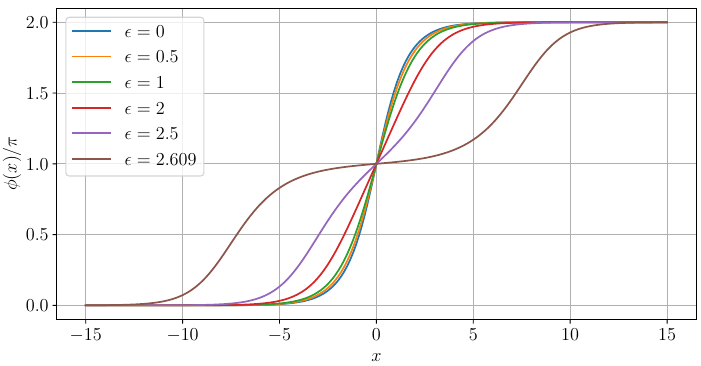
Figure 1 . The potential of the model (2.1) for various values of the parameter (cid:15) . Note that the first and last values plotted are outside the range considered in this paper: for (cid:15) = − 0 . 005 the potential is unbounded below, while for (cid:15) = 3 it does not support finite-energy kink solutions.